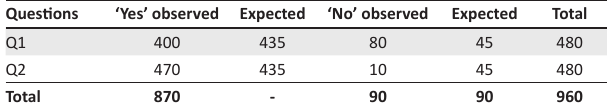
TABLE 4: Observed and expected value question 1 and 2.